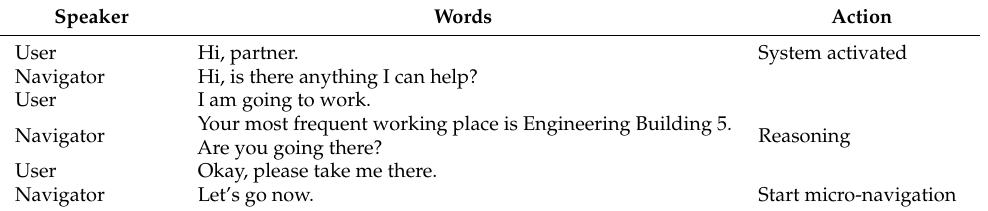
Table 2. Display of the dialogue process of the navigation system in the second scenario.